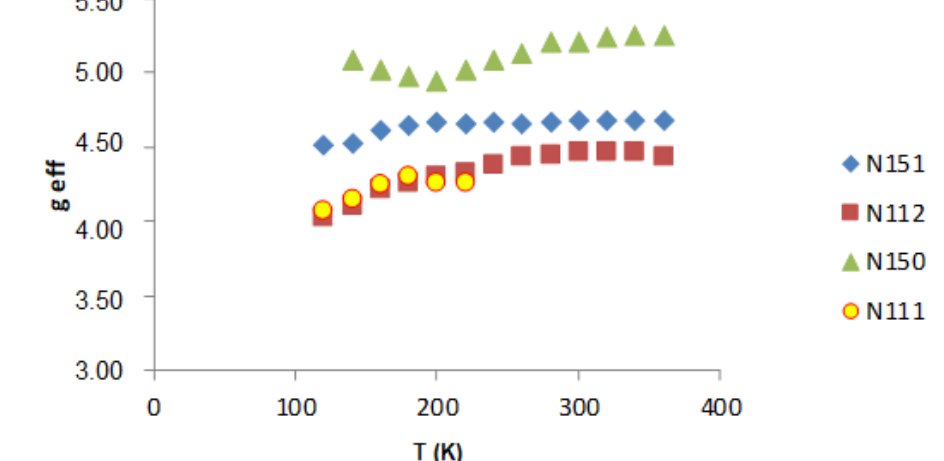
Figure 6. g eff as a function of the temperature for the “ ferromagnetic ” line (g eff ≈ 5).